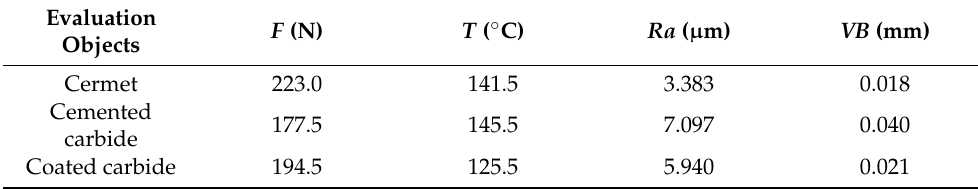
Table 5. Mean values of evaluation indexes at the cutting speed of 40 m/min.